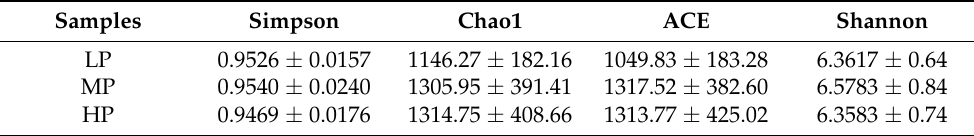
Table 5. Alpha diversity analysis of tilapia intestinal microbial sample sequencing data.